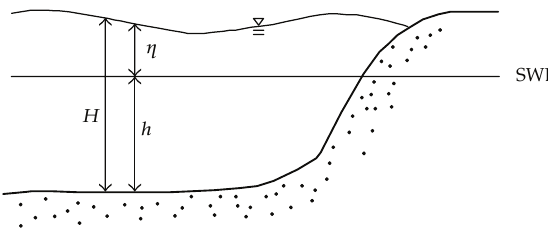
Figure 1: A definition sketch of the free surface displacement and local water